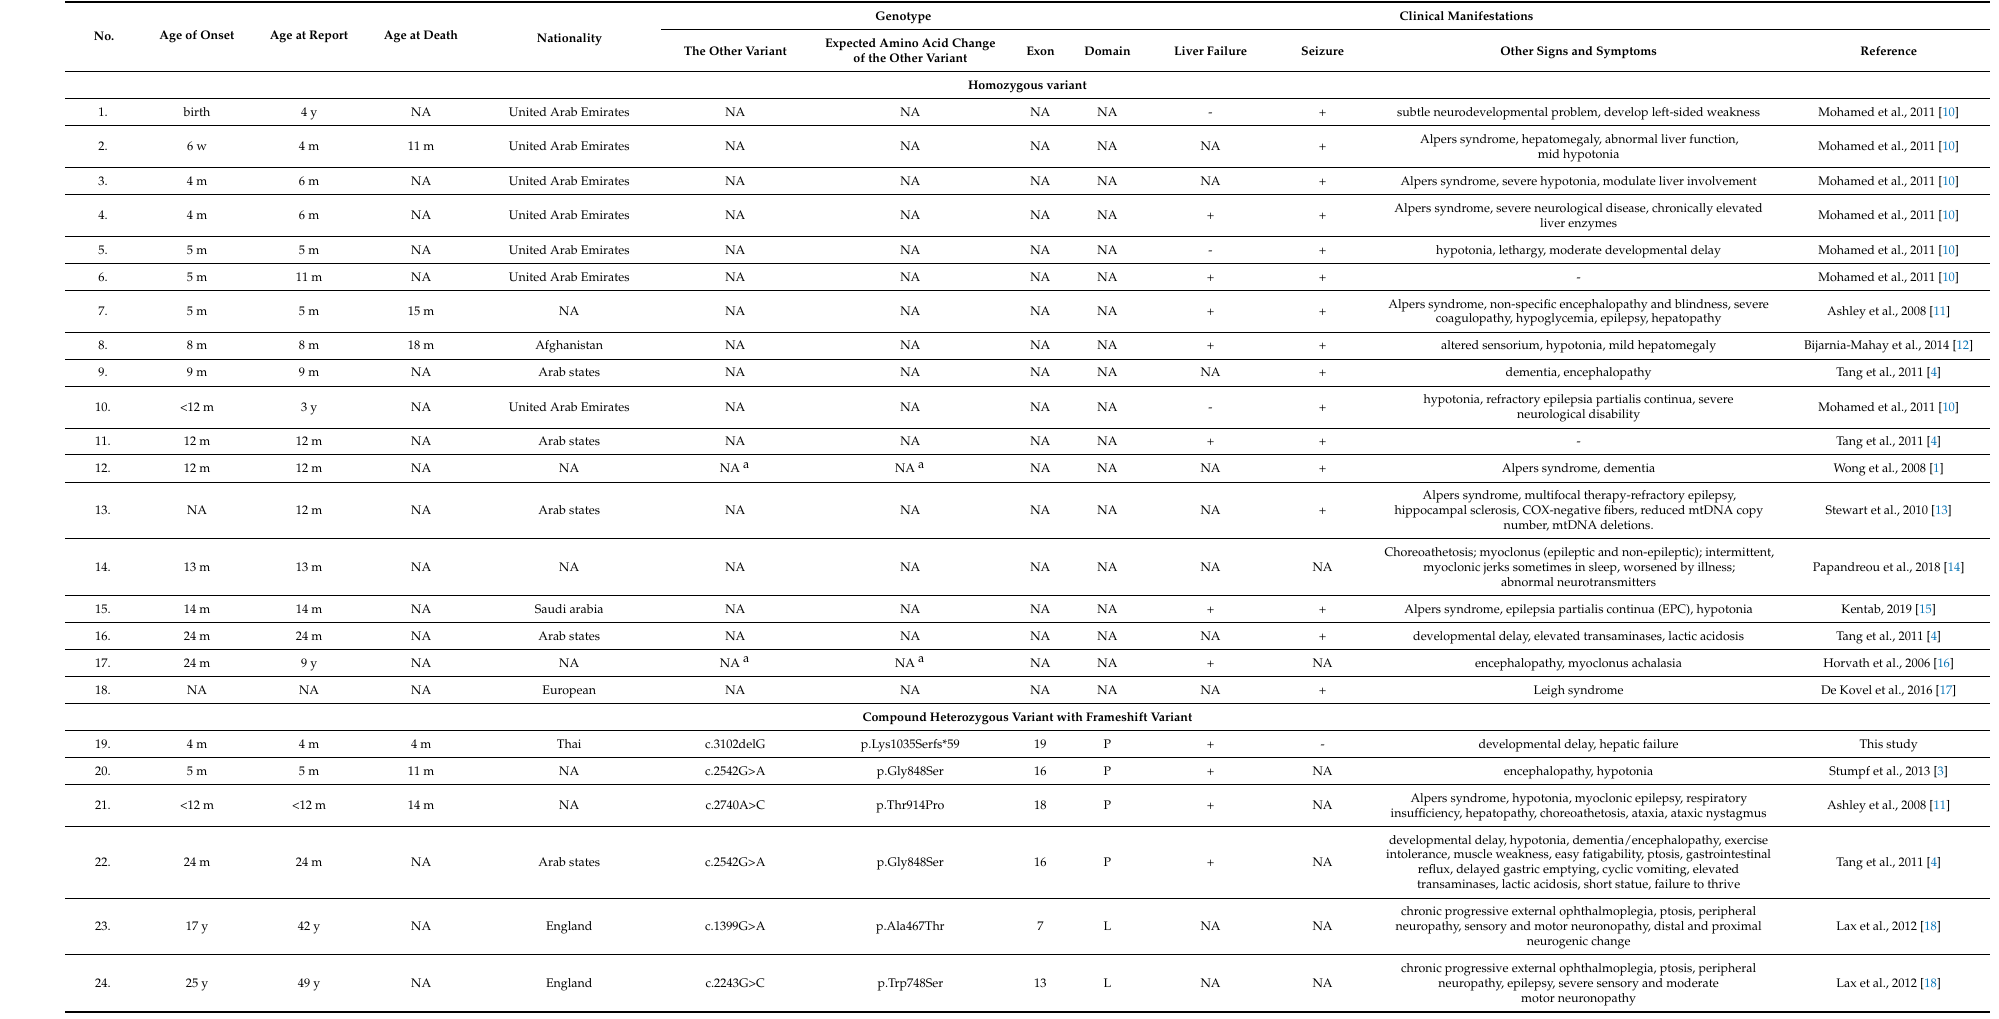
Table 1. The patients reported with the variant, c.3286C>T (p.Arg1096Cys), in exon 21 of the POLG gene